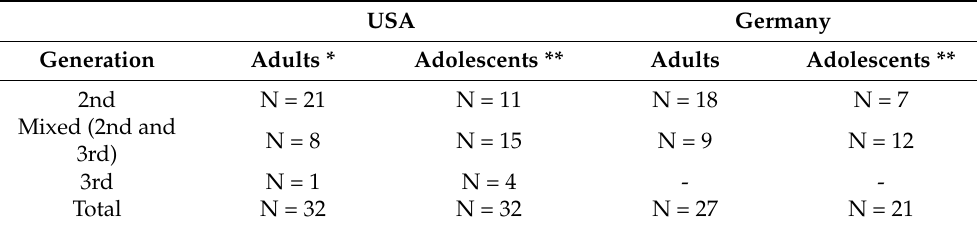
Table 2. Information about our participants’